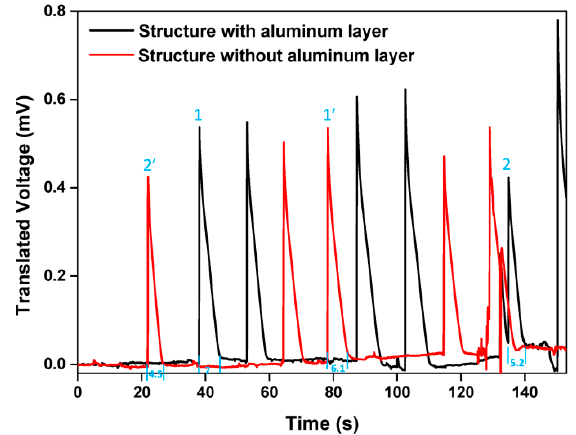
Figure 7. Pulses generated by the electromagnet.